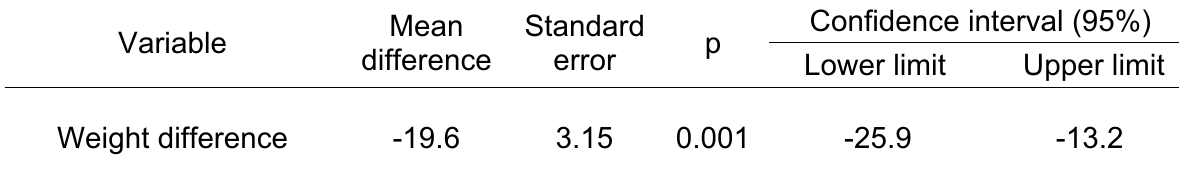
TABLE 3 – Mean difference between pre-reoperative and preoperative weights